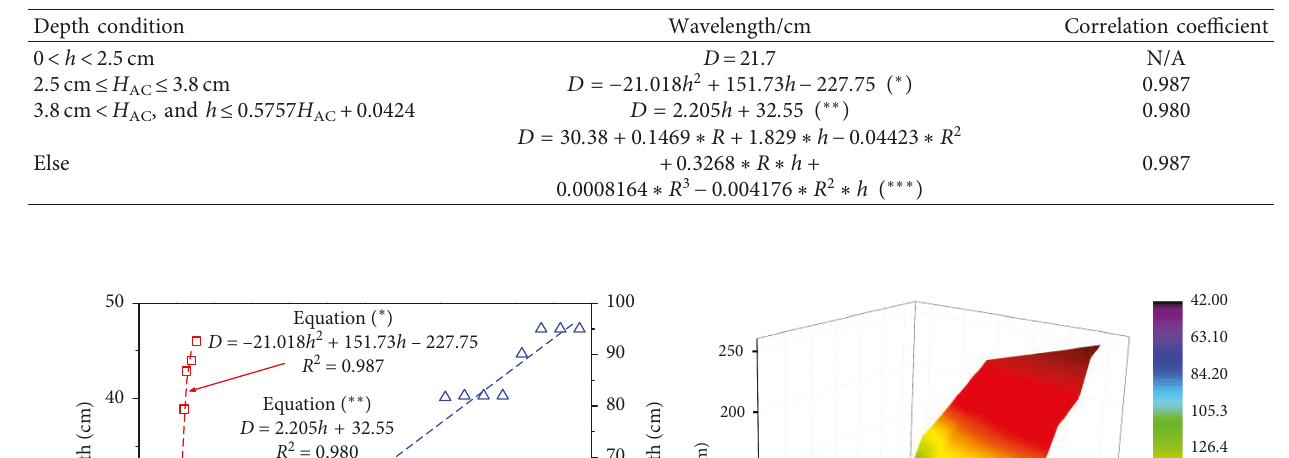
Table 1: Wavelength at different depths.